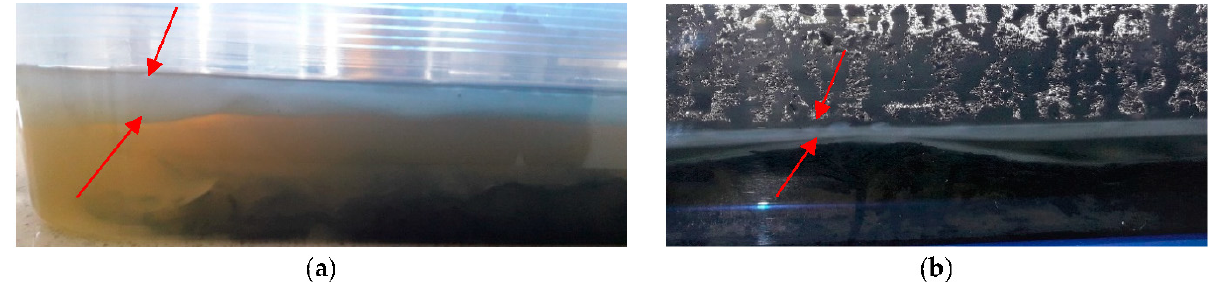
Figure 1. Thickness of bacterial cellulose (red arrows) cultured on: ( a ) SBR + CB; ( b ) SBR + cross- linking substances.